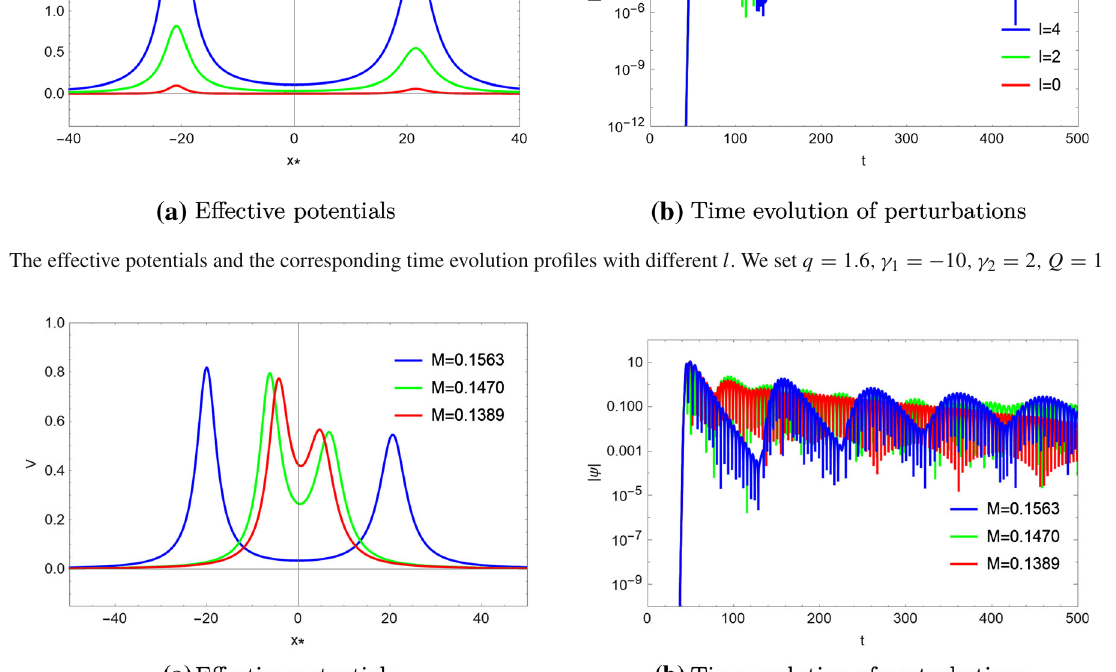
imaginary parts of QNFs have maximum values for different l , while in Table 2 the real and